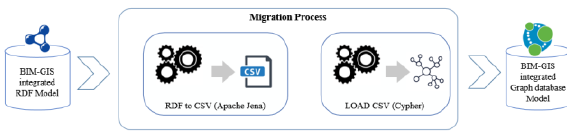
Figure 7. IFC-CityGML to graph database (Neo4j) conversion workflow